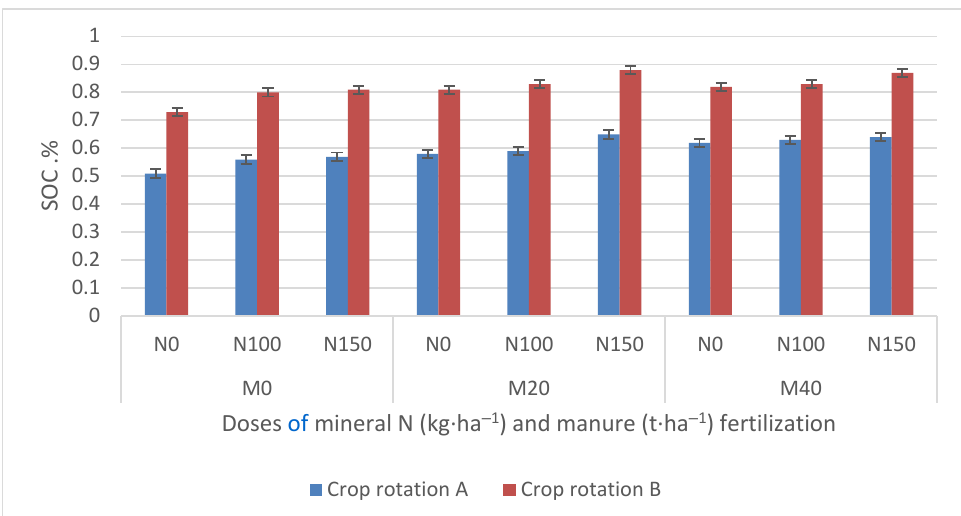
Figure 1. Soil organic carbon (SOC) contents in in the topsoil layer (0–30 cm) as influenced by crop rotation (I), manure application (II) and inorganic N rate (III) in the long-term field experiment at Grabow, Poland. Error bars denote standard deviations ( n = 3). LSD ( p ≤ 0.05): for I = 0.023, II = 0.016, III = 0.015, Interactions: II/I = n.s., I/II = n.s., III/I = 0.0 21, I/III = 0.0 27, III/II = 0.0 25,II/II I = 0.0 26 .